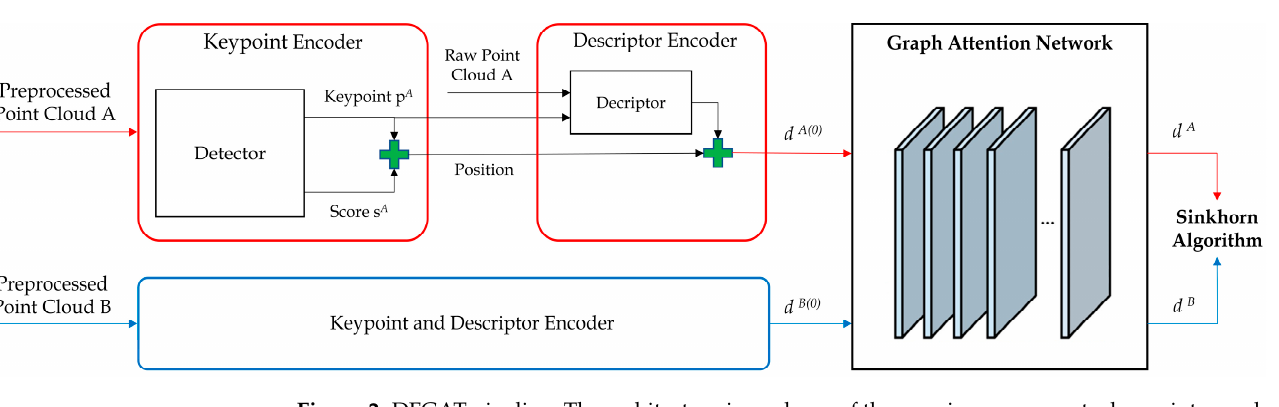
Figure 2. DFGAT pipeline. The architecture is made up of three major components: keypoint encoder (Section 3.1), descriptor encoder (Section 3.2), GAT (Section 3.3).